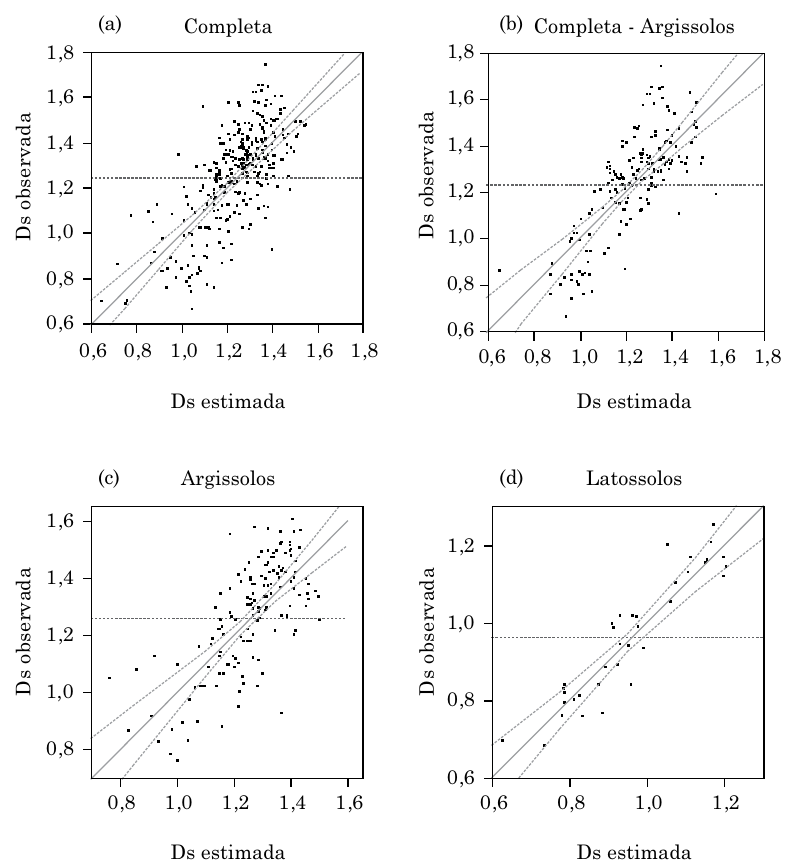
Figura 4. Modelos obtidos para as bases de dados (0-100 cm) completa (a), completa menos argissolos (b), somente argissolos (c) e latossolos (d). as linhas pontilhadas ao longo da linha 1:1 (contínua) mostram o intervalo de confiança para p>0,95, e a linha pontilhada horizontal, a Ds média da